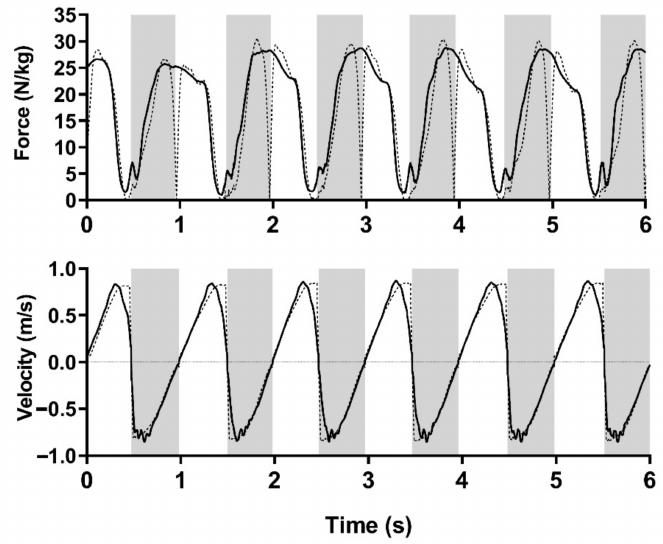
Figure 3. Representative ground reaction force ( upper part ) and linear velocity data ( lower part ) during flywheel squats. Filtered data are presented for six consecutive squat repetitions at inertia 0.225 kg · m 2 . Concentric and eccentric parts of the repetitions were determined from the vertical position data: from the lowest squat position (approximately 90 ◦ knee flexion) to the standing position (approximately 0 ◦ knee flexion). The shaded area represents the eccentric phase of the squat. The dashed line represents the encoder data, and the full line represents the force plate data ( upper part ) or the linear encoder data ( lower part